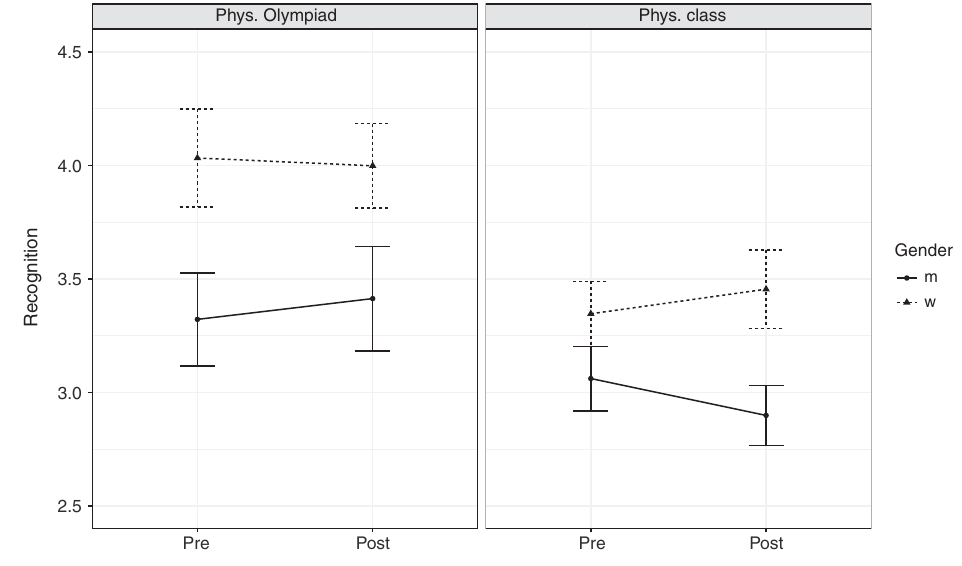
FIG. 4. Means and standard errors for recognition over time with regard to gender.